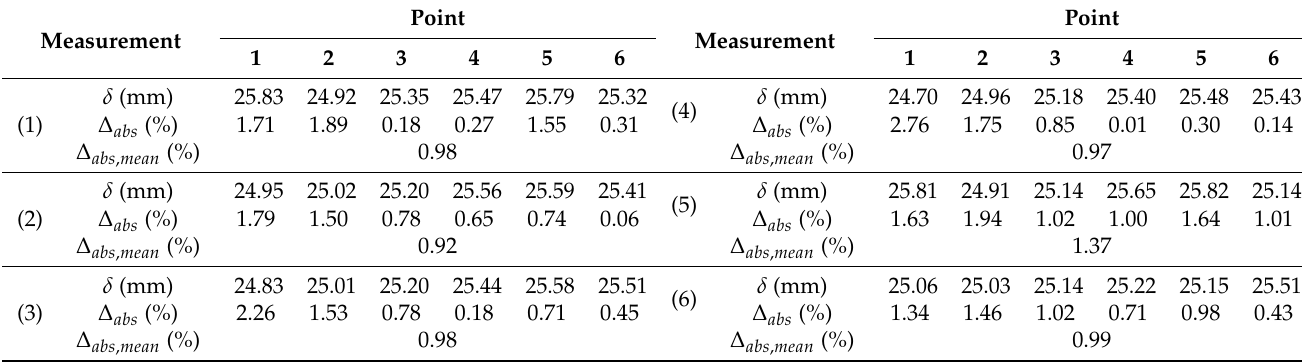
Table 6. Measurement accuracy from one-inch steel block experiments using enhanced images.